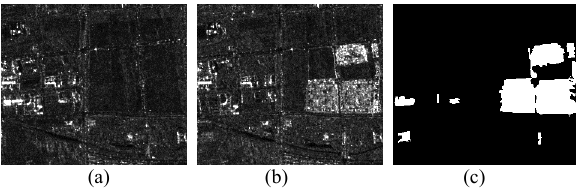
Figure 5. Weishanzhuang dataset. (a) Image acquired in April 2017. (b) Image acquired in May 2018. (c) Reference